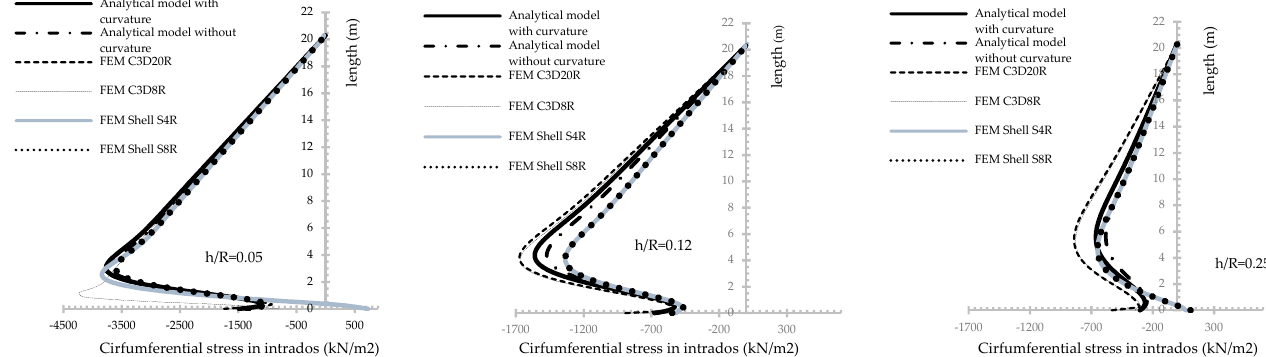
Figure 9. Circumferential stress in intrados for thin, medium and thick shells, considering different models.